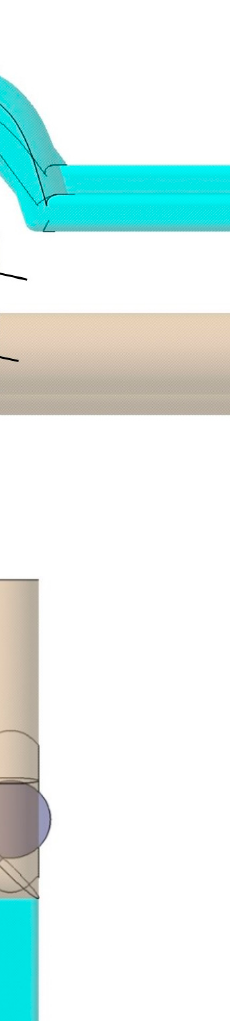
Figure 10. Design parameters P ch y C ch of the conformal refrigeration layout in the cavity plate.